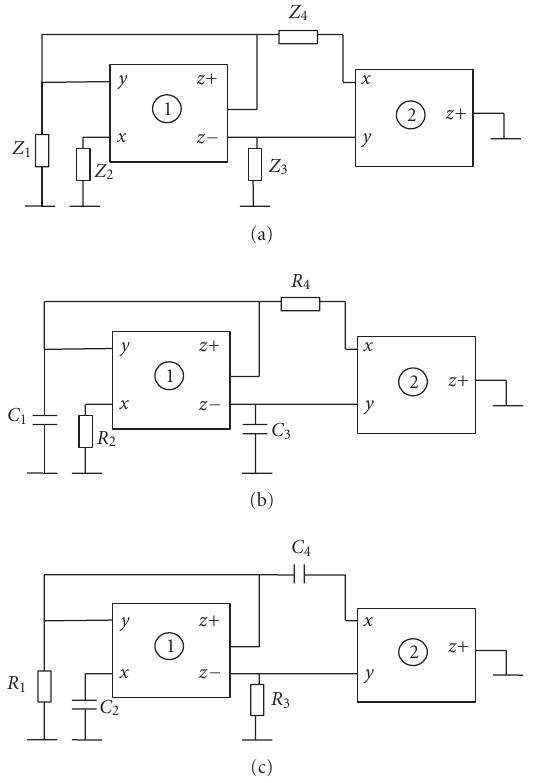
Figure 2: (a) Second proposed circuit topology, (b) Type2 oscilla- tor, and (c) Type1